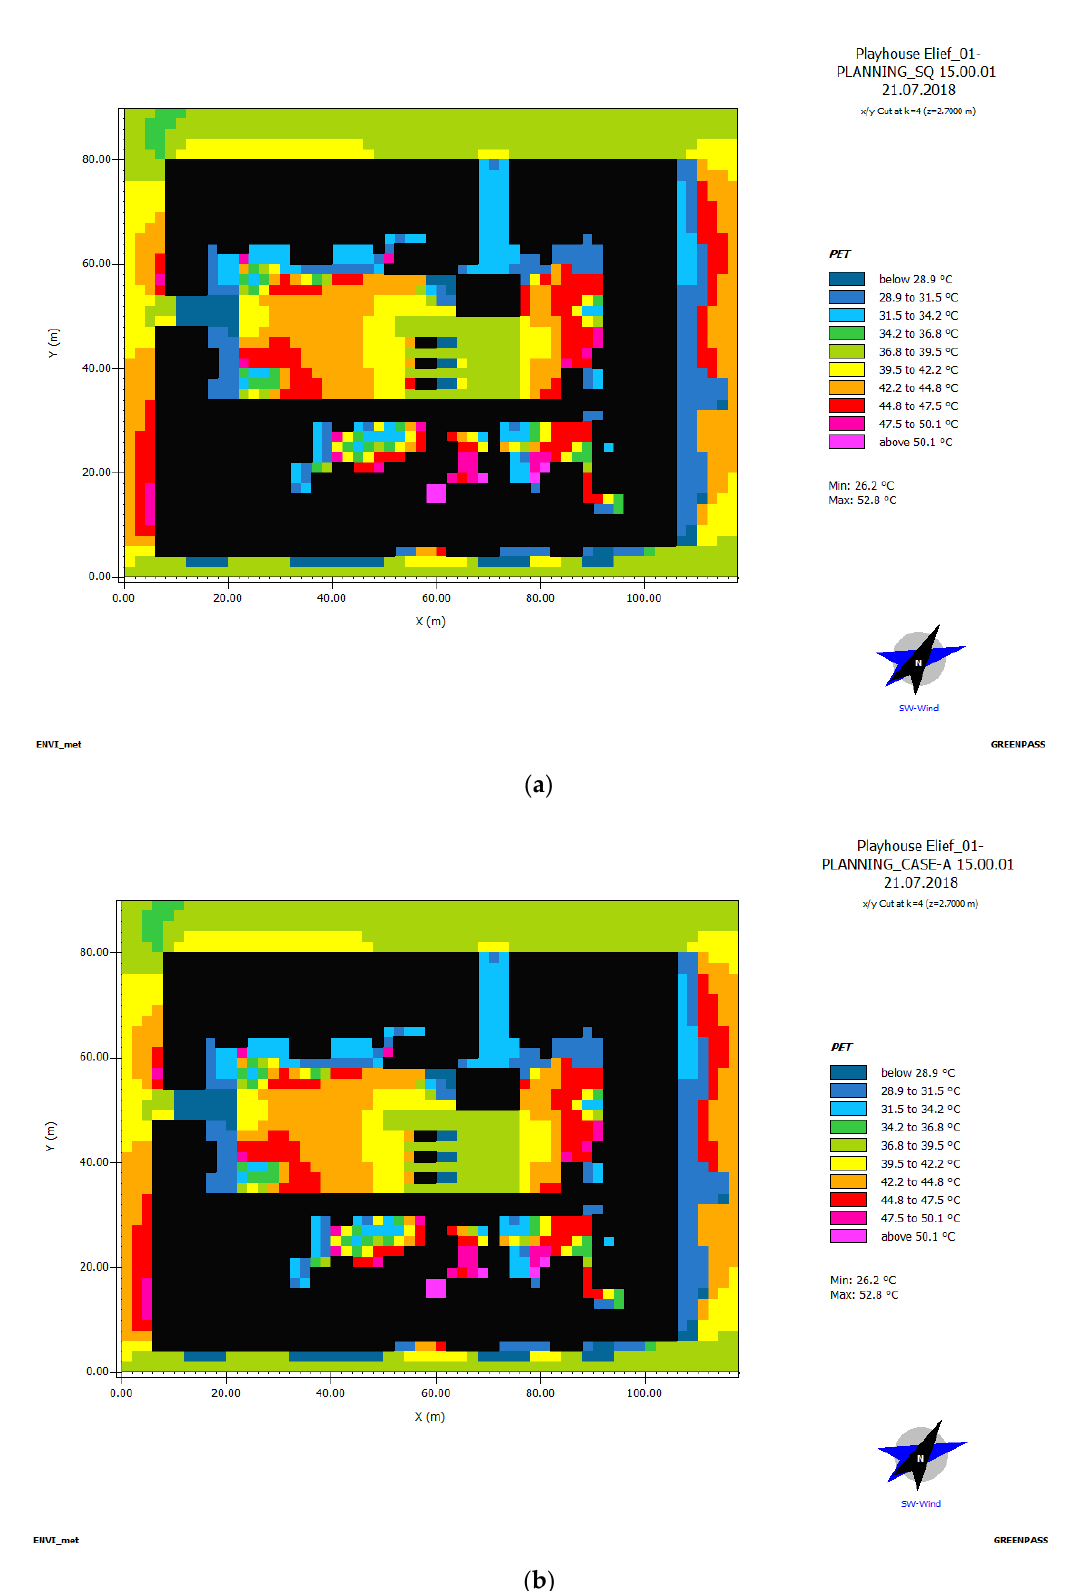
Figure 7. Results of microclimatic simulation Playhouse Elief Antwerp, comparison on a hot summer day 21.7. ( a ) Variant SQ—Physiological equivalent temperature (PET) 15:00 at ground level; ( b ) Variant A—PET 15:00 at ground level; ( c ) Variant B—PET 15:00 at ground level.